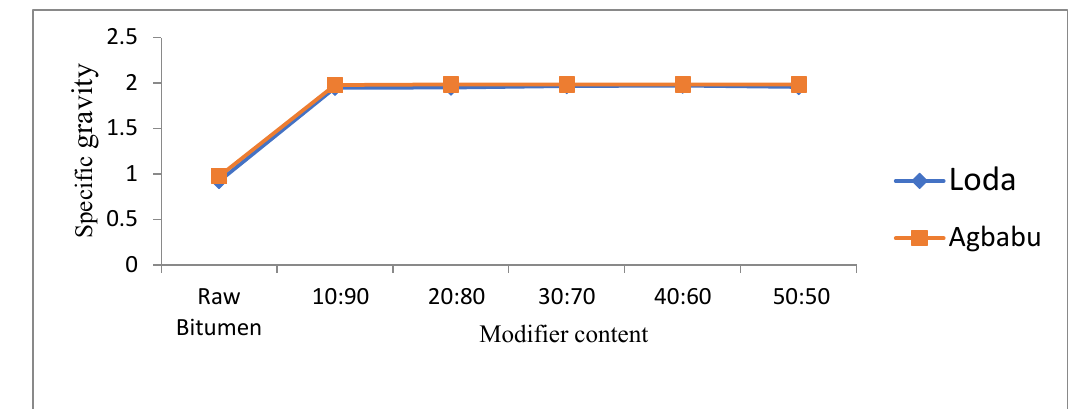
Fig. 5: Penetration in raw bitumen and modifier content